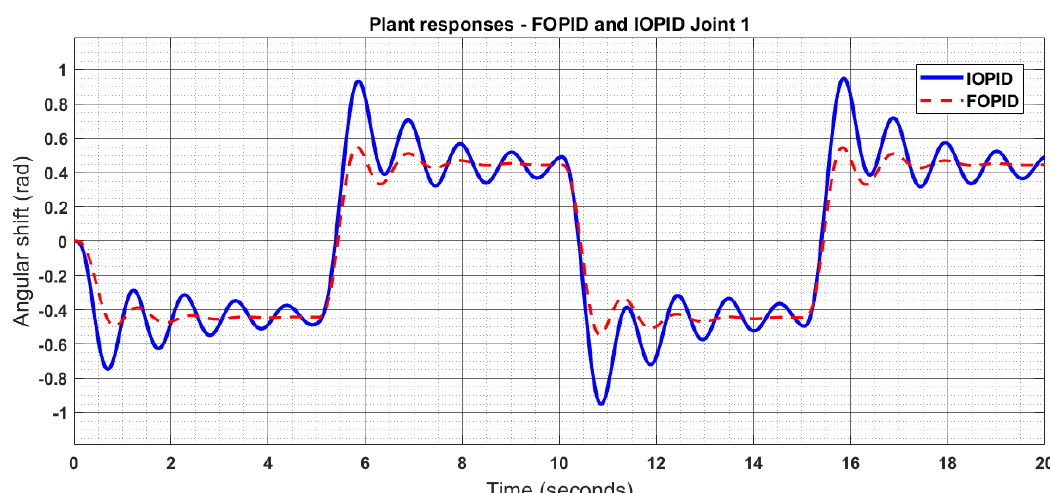
Figure 9. Controller responses for angular position ( θ ) for Joint 1.